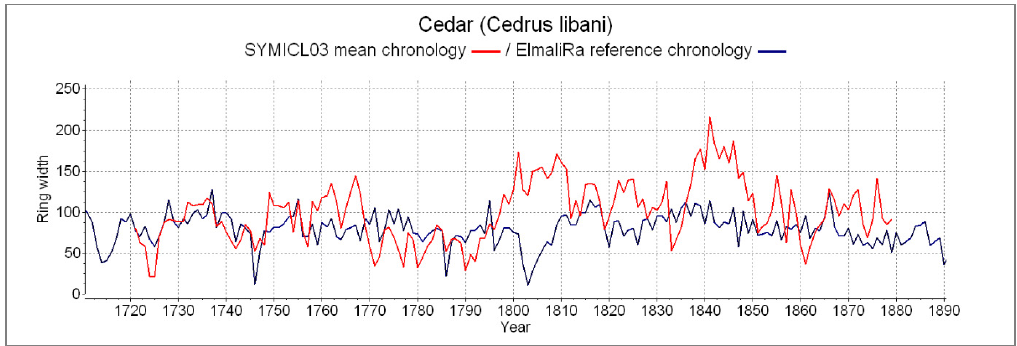
Figure 5. Visual cross-matching of the cedar chronology (SYMICL03, in red) with the Cedrus libani chronology from Turkey (Elmal ı Ra, in blue) [38]. Only the overlapping period of the two chronologies is presented here.